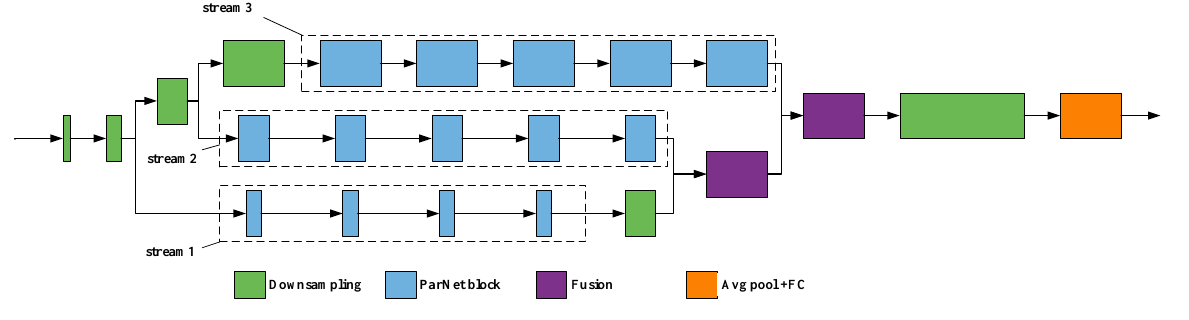
Figure 6. Structure of ParNet.